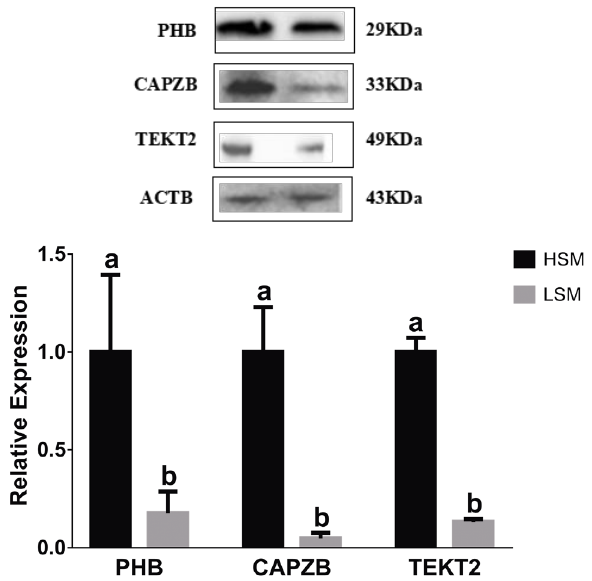
Figure 6. PHB, CAPZB, and TEKT2 protein expression in the sperm samples with high and low motility. 1, the sperm sample with high motility; 2, the sperm sample with low motility. PHB, prohibitin; CAPZB, capping actin protein of muscle Z-line beta subunit; TEKT2, tektin-2. Data represent mean±standard deviation of three replicates, and the different superscripts in the same table indicate significant difference (p<0.05).